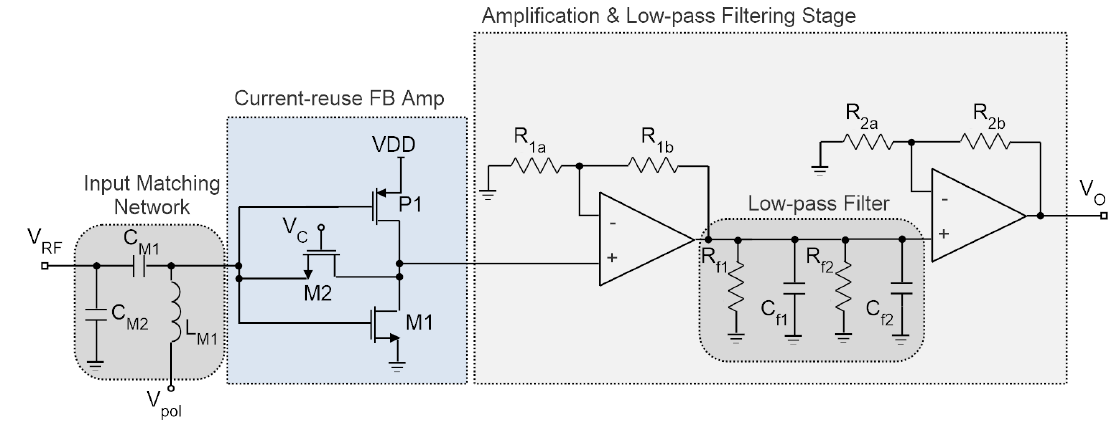
Figure 9. RFED WuR with current-reuse amplifier [8].